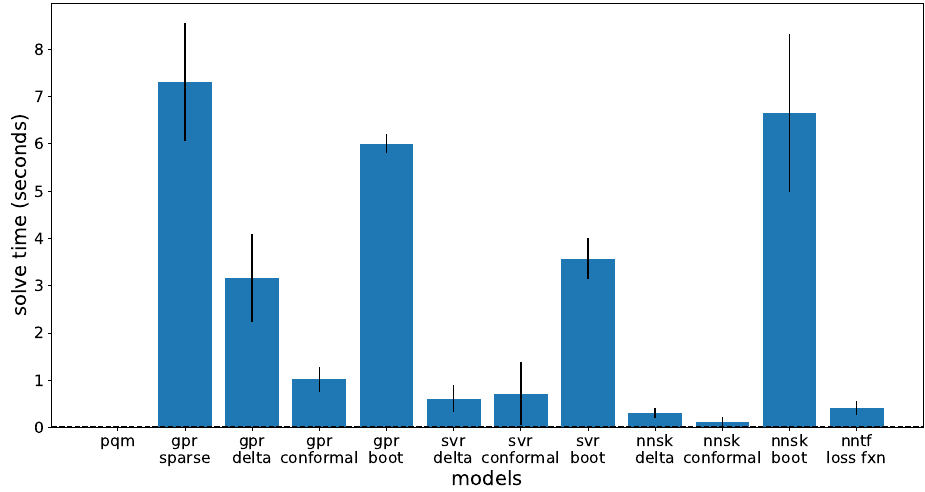
Figure 8. Time used to solve simplified optimization problem. Shown in Figure 9 is the optimization target, the waste loading. By optimizing different input parameters like composition of glass formers, the numerical optimization routine used by Gekko tries to maximize waste loading. The conformal SVR as well as the delta uncertainty ANN have the highest waste loading, but also have a large variation between the different training splits. Most other models also have a slightly higher average waste loading than a PQM with a slightly larger variance.